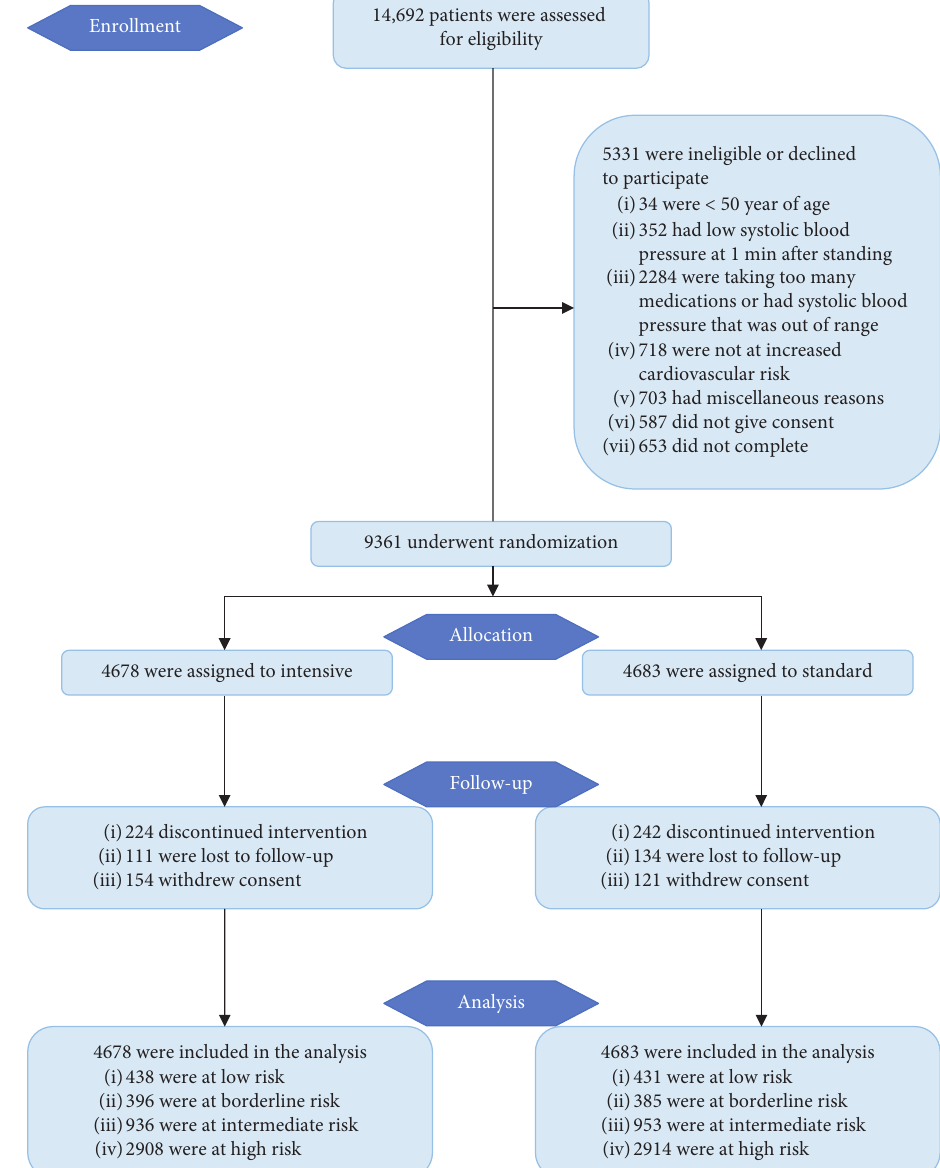
Figure 1: CONSORT flow